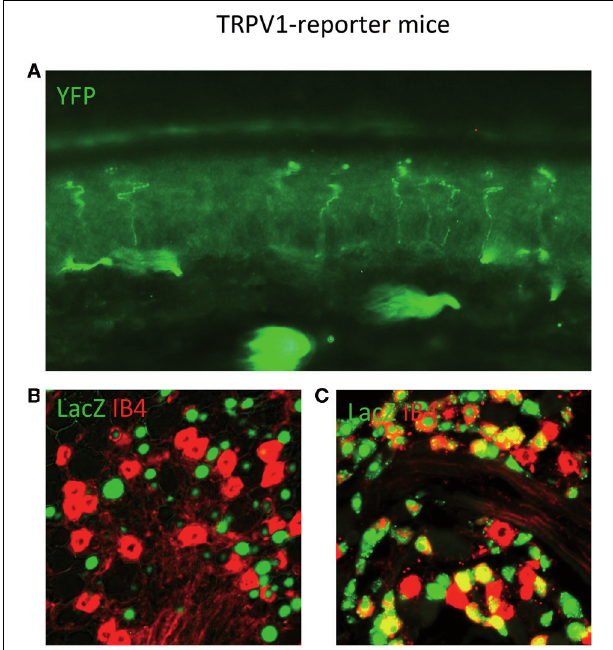
FIGURE 3 | TRPV1 Reporter mice reveal the anatomy of neurons that expressed TRPV1 throughout their lineage. (A) Skin section from TRPV1-Cre × YFP reporter strain showing primary afferent arborizations in the various epidermal layers. (B) DRG section from adult TRPV1-PLAP-nlacZ mouse, showing minimal overlap between β -Gal reaction product (green) and IB4 (red). (C) DRG section from adult TRPV1-Cre × LacZ reporter strain. Anti-LacZ (green) shows significantly more overlap with IB4 (red) since the entire TRPV1 lineage is marked. Image courtesy of Danial Cavanaugh and Allan Basbaum, Department of Anatomy